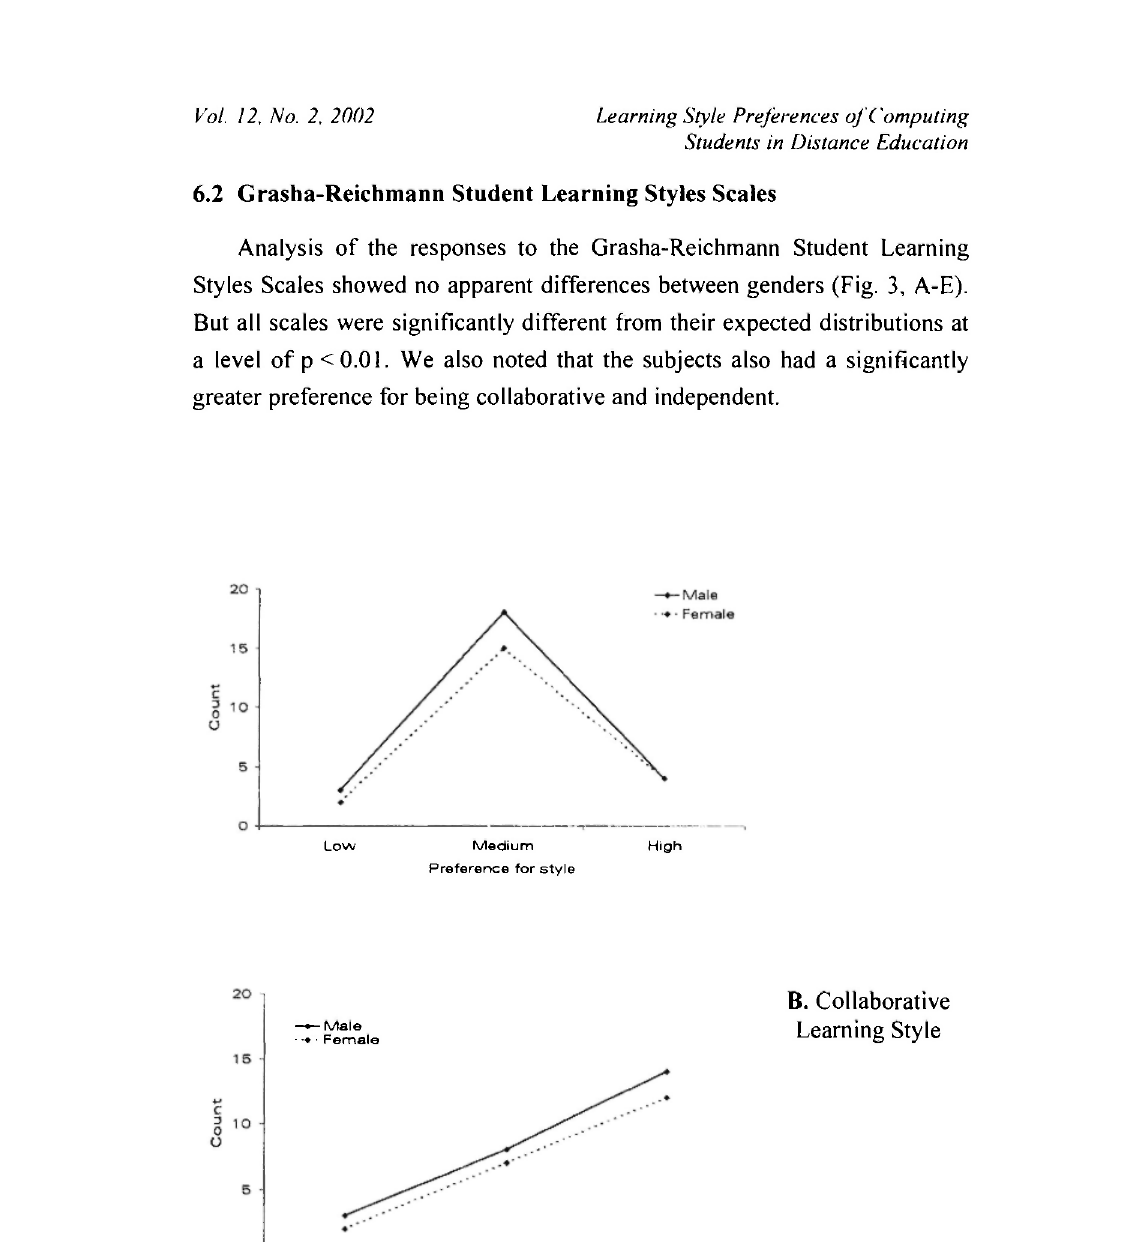
Fig. 3: Α-B, Frequency of preference for Grasha-Reichmann learning styles by gender